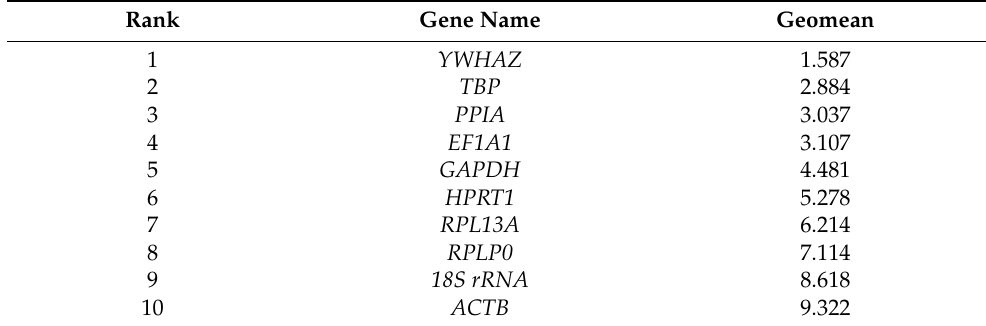
Table 4. Overall comprehensive ranking by geometrical